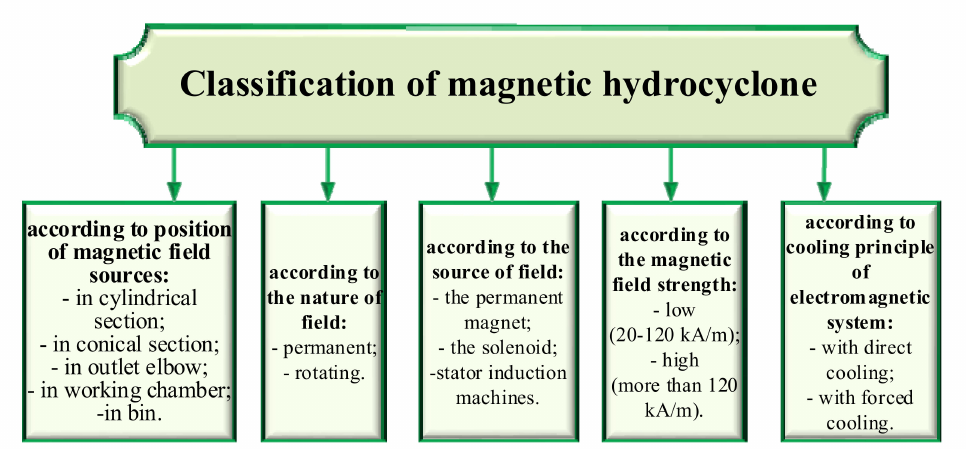
Figure 1. Classification of magnetic hydrocyclones.